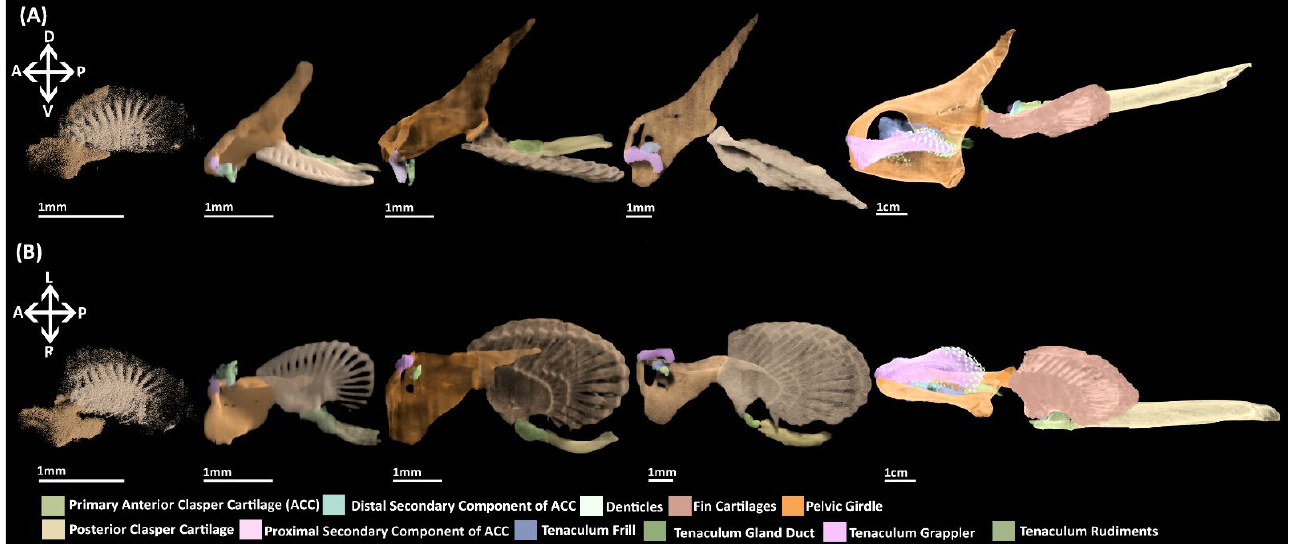
Figure 10. NanoCT models of the development of the pelvic skeleton in C. milii . ( A ) Models observed in a distal lateral view; ( B ) Models in a ventral view. Anatomical orientation of models indicated by A-anterior D-dorsal P-posterior R-right L-left V-ventral.